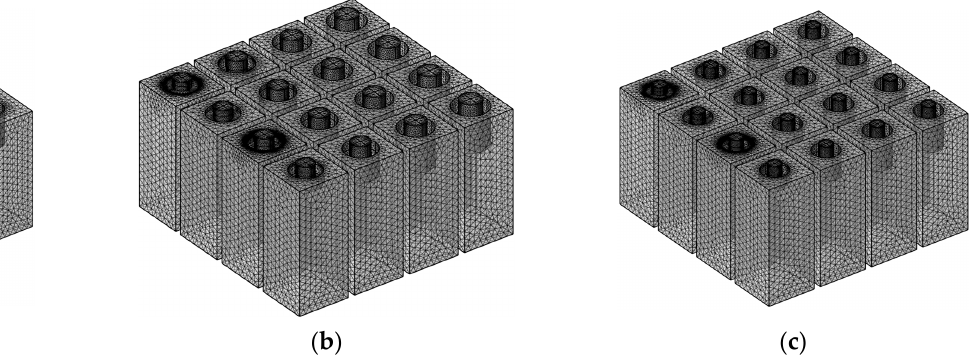
Figure 15. Three-dimensional finite element simulation model for the multiple parallel connection HRs with normal cylindrical aperture. ( a ) The radius of aperture is equal to upper plane R u ; ( b ) the radius of aperture is equal to middle plane R m ; and ( c ) the radius of aperture is equal to (R u + R m )/2.